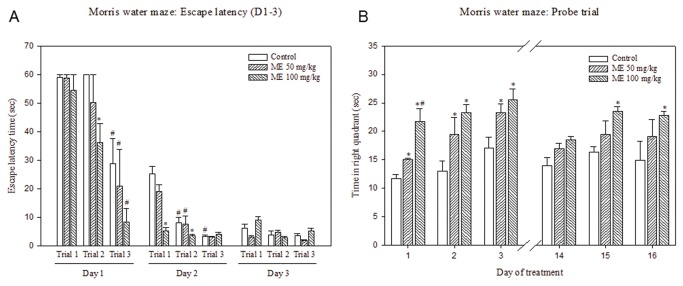
Effects of ME on spatial memory in mice.(A) Effects of ME on escape latency during 3 test trials of day1, 2 and 3 of the treatment using Morris water maze test. ME (50 or 100 mg/kg) or water (control) was orally administered to the mice 45 min before the trials (n=6). The escape latency (sec) was expressed as Mean ± SEM. * P < 0.05 compared to control in the same test trial on the same test day; # P <0.05 compared to the trial 1 of the same test condition in the same test day. (B) Effects of ME on time in right quadrant (probe trial) on day 1-3 and 14-16 of the treatment using Morris water maze test. The mice were orally administered with water (control) or ME (50 and 100 mg/kg) at 45 minutes before the test. The escape latency (sec) was expressed as Mean ± SEM (n=6). * P < 0.05 compared to control on the same test day; # P < 0.05 compared to 50 mg/kg ME-treated group on the same test day.